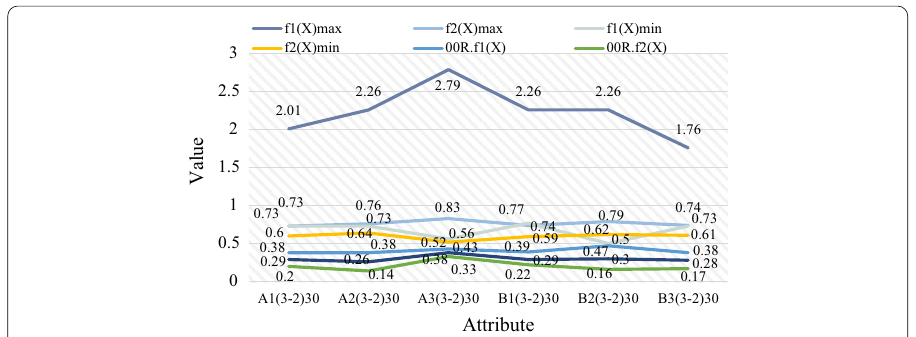
Fig. 8 Experiments 1–6, calculation results of the optimization range of each target